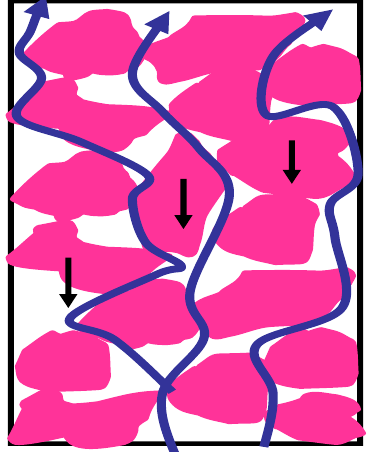
Figure 20. Moving Bed Gas Solids Flow Patterns.